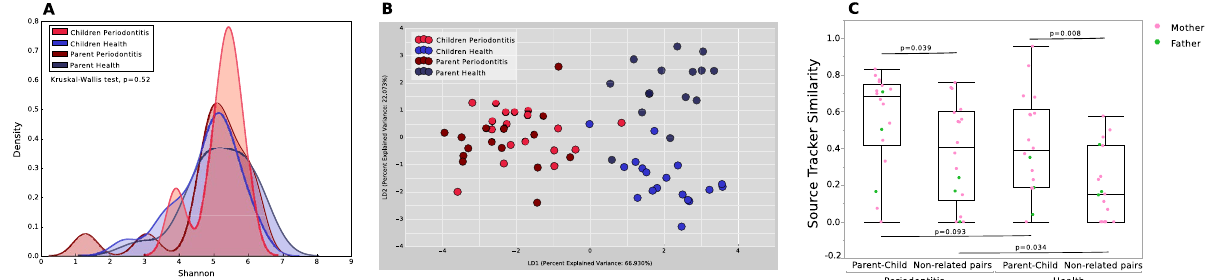
Figure 2. The similarity between parents’ and children’s microbiome. ( A ) α-diversity, Shannon estimator. ( B ) β-diversity, LDA of Morisita-Horn Dissimilarity Index showing the children and their parents in both groups. ( C ) Source Tracker results with the similarity between a parent and their child and a parent and a non-related child in the periodontitis and health